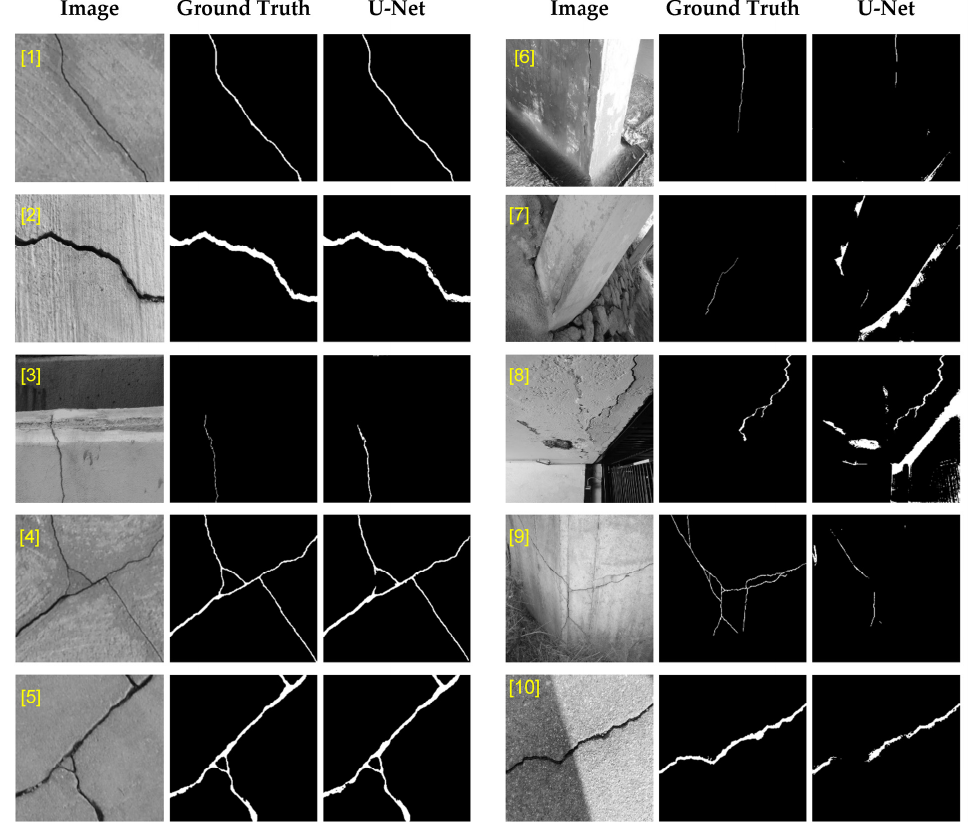
Figure 4. Samples of public dataset images and their corresponding masks ([1]-[5]: cases where U-Net successfully predicted the crack pixels; [6]-[10]: cases where U-Net missed parts of the crack or mistakenly detected other objects in the background as crack).